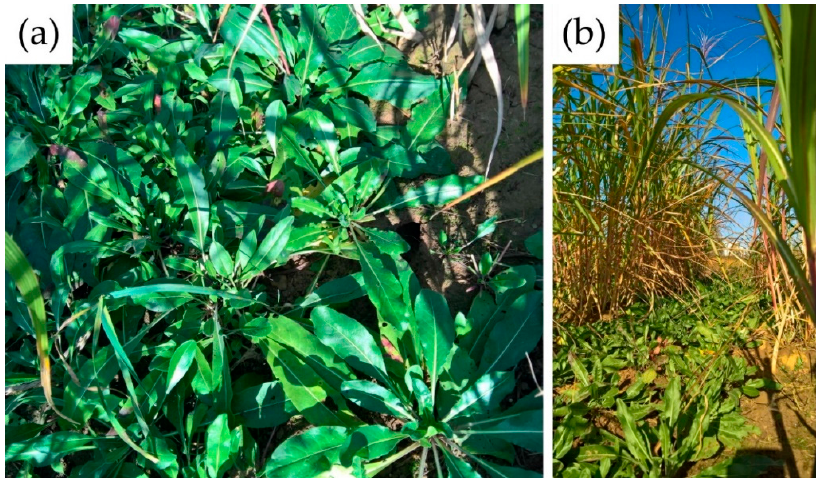
Figure 7. Morphology of woad after the vegetation period in 2017 (view from above ( a ), and from the side ( b ). The pictures were taken on 31 October 2017.